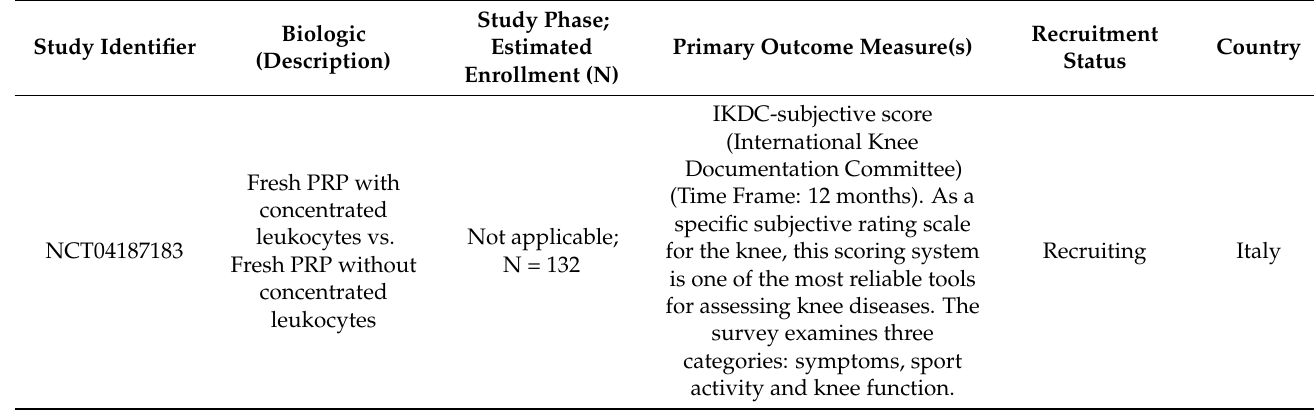
Table 1. Ongoing clinical trial registered on ClinicalTrials.gov from 29 December 2022 comparing leukocyte-rich vs. leukocyte-poor Platelet-rich Plasma for treatment of knee